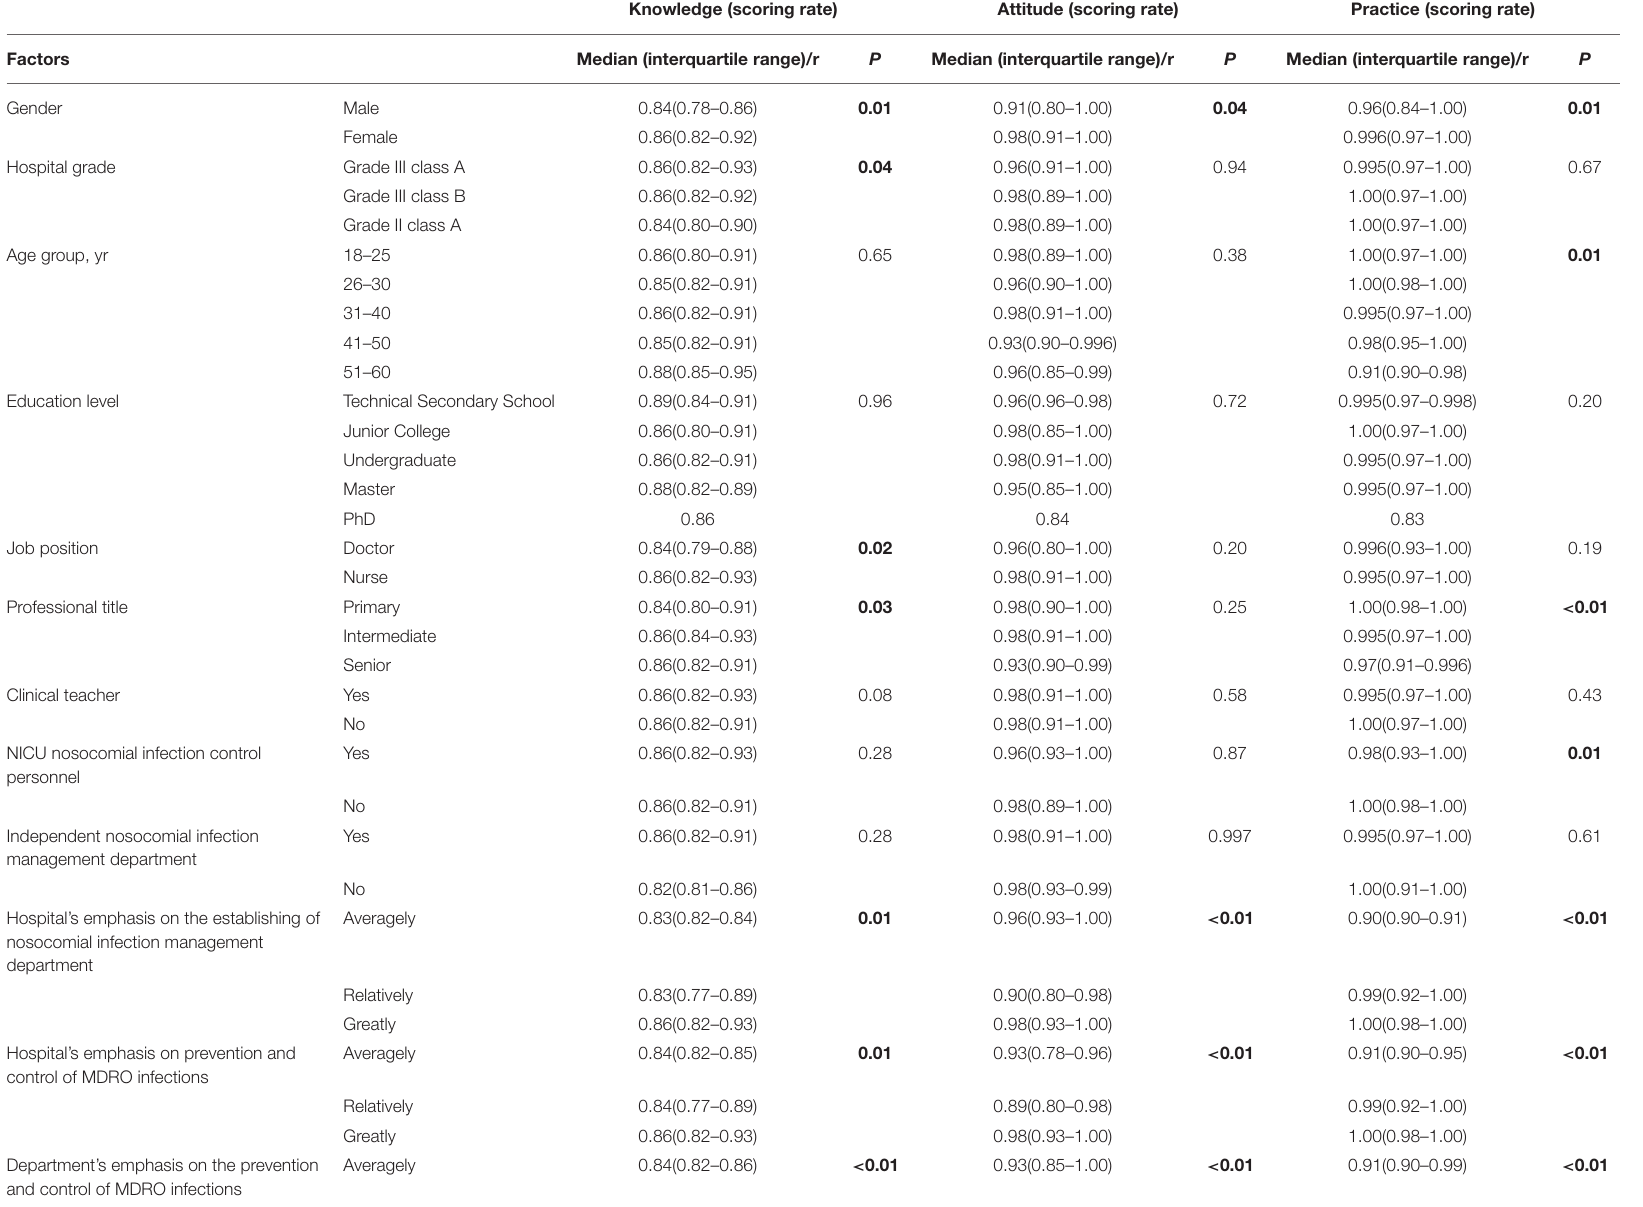
TABLE 3 | Univariate analysis of KAP †